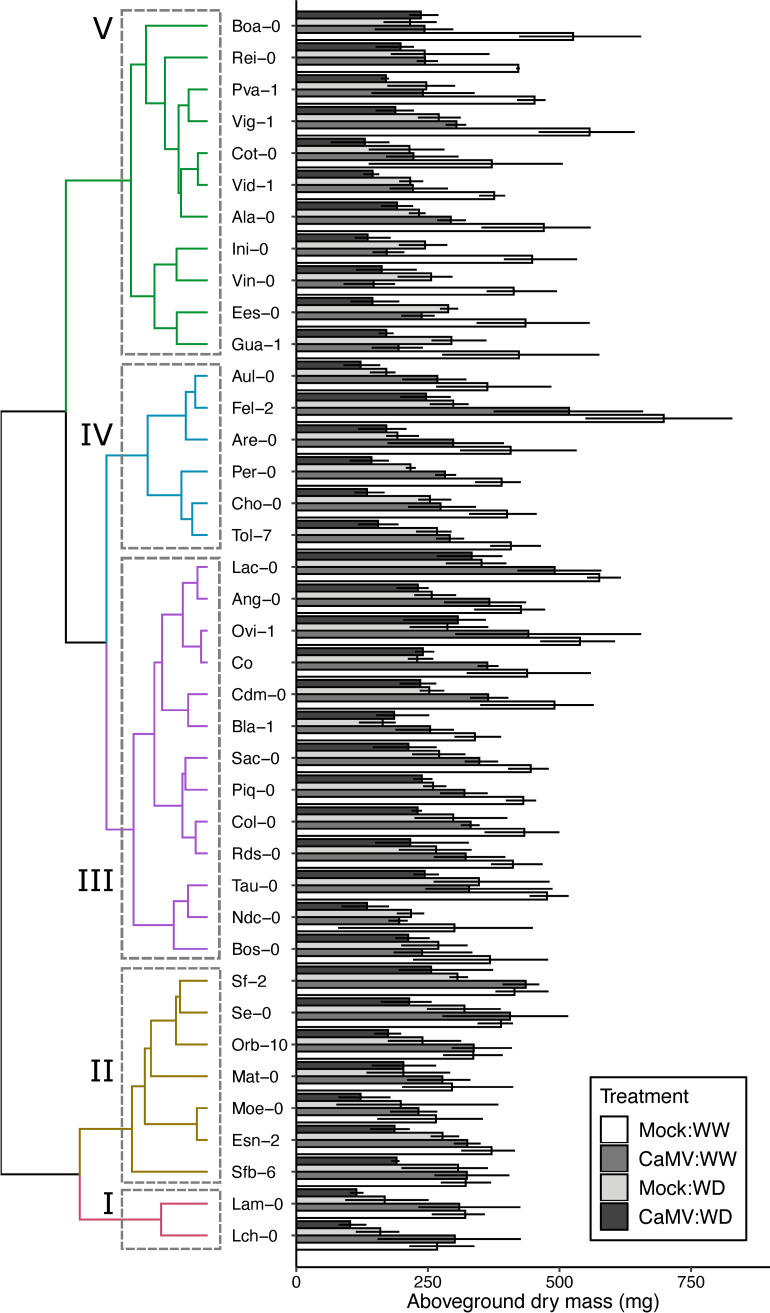
Effects of CaMV infection and watering on growth of 39 accessions of A. thaliana.(Left) Clustering based on joint Euclidean distance of the changes in aboveground dry mass (%) in response to infection with CaMV, soil water deficit (WD) and combination of both treatments, relatively to mock-inoculation under well-watered (WW) conditions. Color of the branches in the dendrogram highlights five clusters of accessions with similar responses. (Right) Bars are mean ± bootstrapped 95% CI of aboveground dry mass at 30 dpi (n = 3) of plants grown in mock-inoculated:WW (white bars), CaMV-infected:WW (dark grey bars), mock-inoculated:WD (light grey bars) and CaMV-infected:WD (black bars) conditions. Data are from Experiment 1.